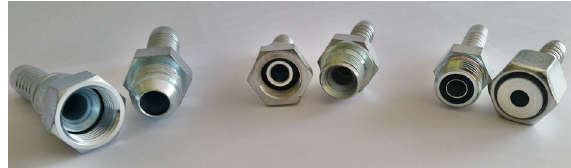
Figure 2. View of the standards of fitting connections